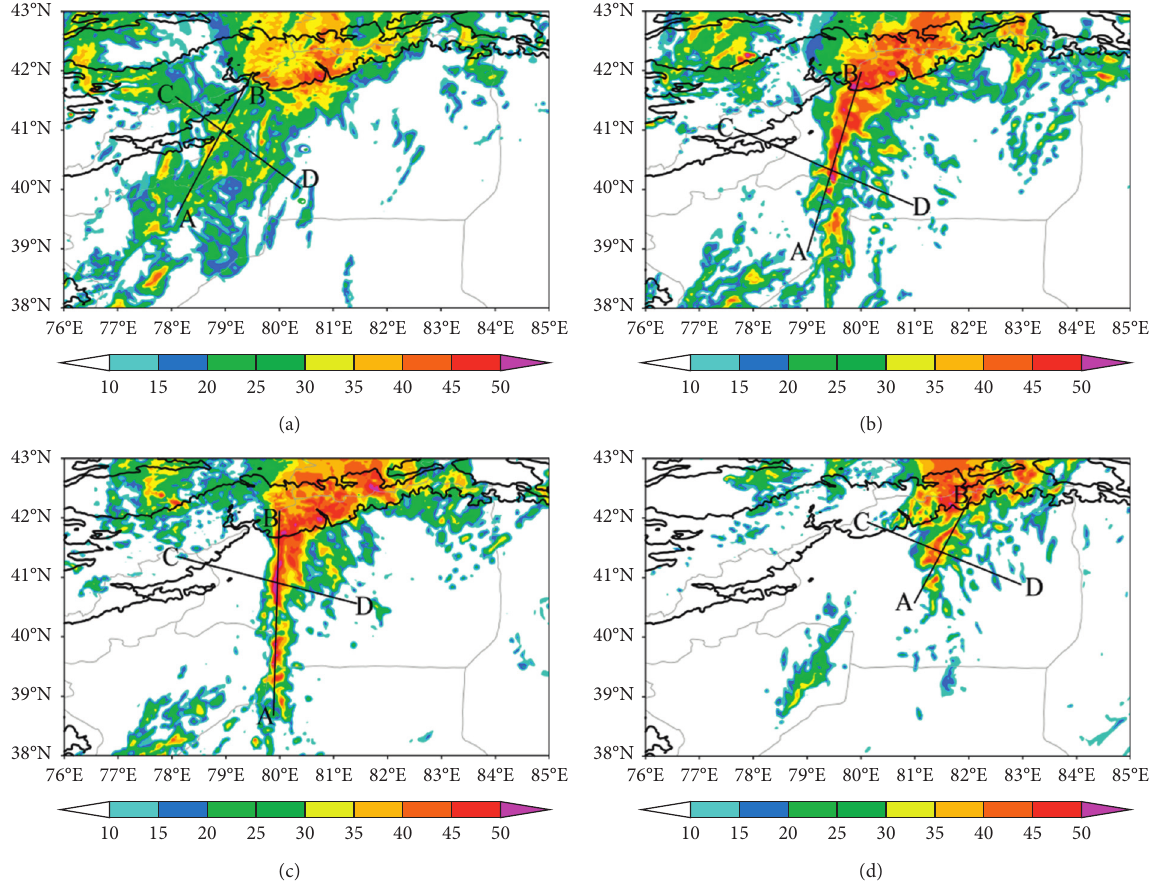
Figure 5: Simulated radar reflectivity in four stages of rainstorm system evolution (shadow; unit, dBZ; the solid black line represents the terrain of the Tianshan Mountains above 3000m). (a) Initiation stage at 12:00 on July 31, (b) development stage at 16:00 on July 31, (c) maturity stage at 17:30 on July 31, and (d) extinction stage at 22:00 on July 31,